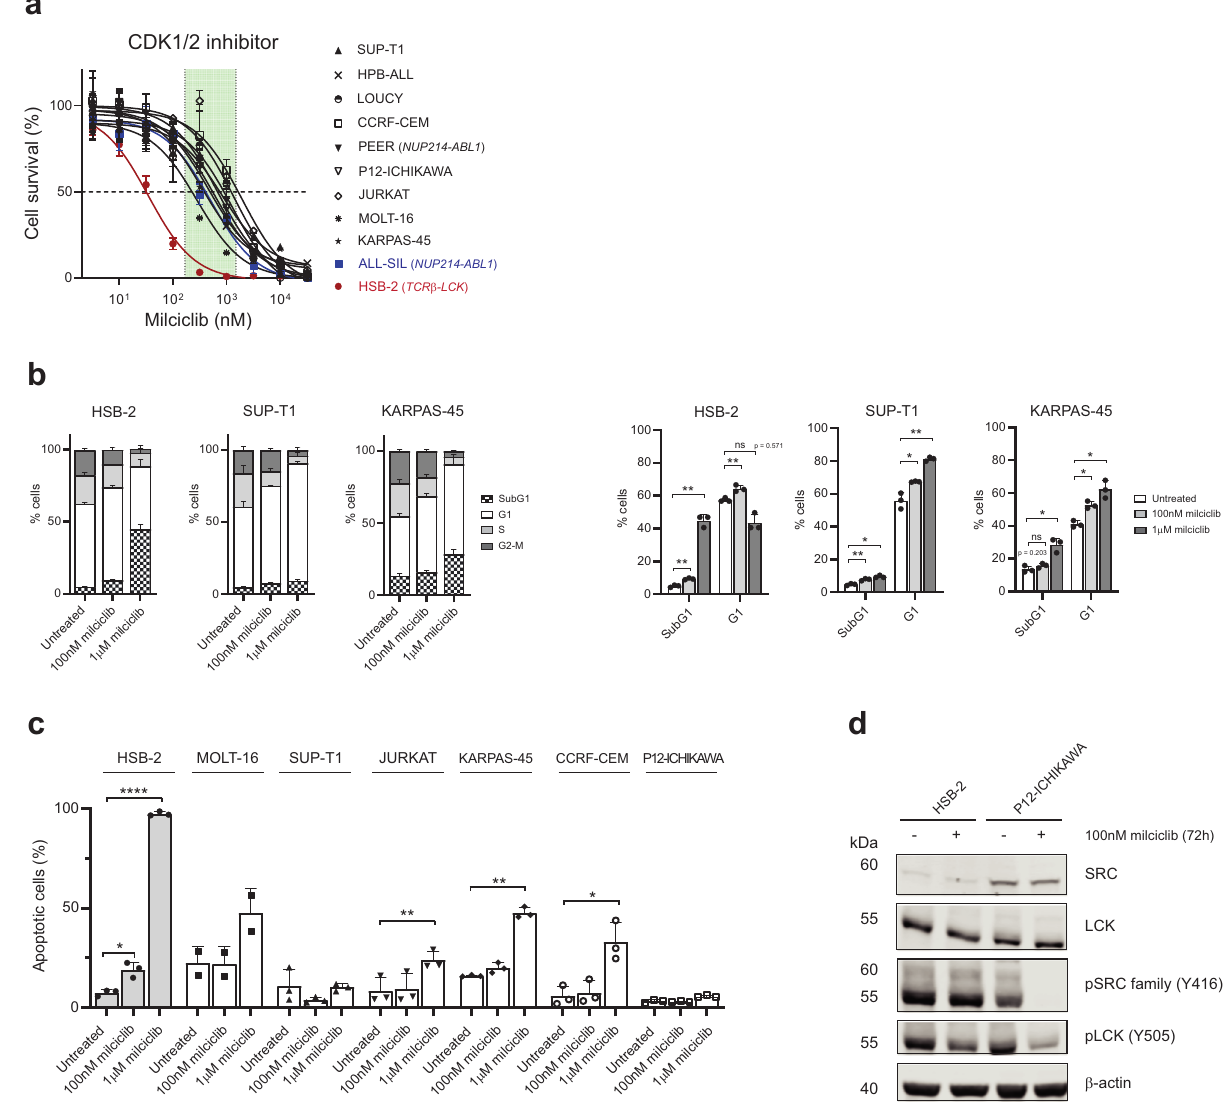
Fig. 2 The CDK1/2 inhibitor milciclib induces G1 arrest in T-ALL cell lines. a Dose-response curves of milciclib treatment in 11 T-ALL cell lines. Cells were treated with increasing concentrations of milciclib (3.2 nM – 32 µ M range) in triplicate and cell viability was assessed after 72 h using the colorimetric MTT assay. Cell survival was calculated in comparison to the untreated control. Each point represents the mean and standard deviation of the triplicate. The green box shows the corresponding clinical concentration range of milciclib used in patients enrolled in clinical trials 51 . b Cell cycle analysis upon milciclib treatment. Cells were treated with either 100 nM or 1 µ M milciclib for 72 h and cell cycle analysis was performed via Hoechst-DNA staining and FACS analysis. The graphs show the average and standard deviation of three independent experiments. Signi fi cance was determined using a paired, two-tailed Student ’ s t -test and annotated as “ ns ” (not signi fi cant, p ≥ 0.05), * ( p < 0.05), ** ( p < 0.01). c Detection of apoptotic cells upon milciclib treatment. Cells were treated with either 100 nM or 1 µ M milciclib for 72 h and Annexin V/ Propidium Iodide (PI) staining was used to detect apoptosis. Apoptotic cells were identi fi ed as the sum of the Annexin V + cells and Annexin V + /PI + cells. The percentage of apoptotic cells is calculated compared to untreated control cells. The graphs show the average and standard deviation of three independent experiments. Signi fi cance was determined using a paired, two- tailed Student ’ s t -test and annotated as *( p < 0.05), **( p < 0.01), ****( p < 0.0001). If not annotated, the results were not signi fi cant ( p ≥ 0.05). d Western blot analysis upon milciclib treatment. HSB-2 cells and P12-ICHIKAWA cells were treated with 100 nM milciclib for 72 h and 20 µ g of protein was used for each condition. The image is representative of three independent experiments. Source data are provided as a Source Data fi le.